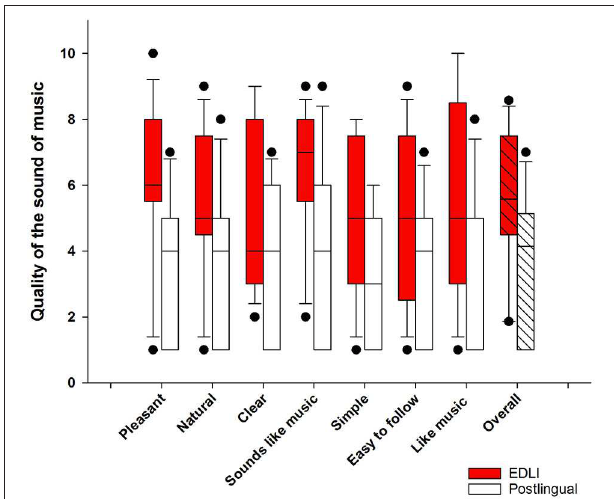
FIGURE 2 | The self-perceived quality of music for EDLI (in red) and postlingually deafened CI users (in white). The boxes represent the 25–75 percentile, the lines the median values, and the error bars the 10–90 percentile. The dots indicate the outliers.